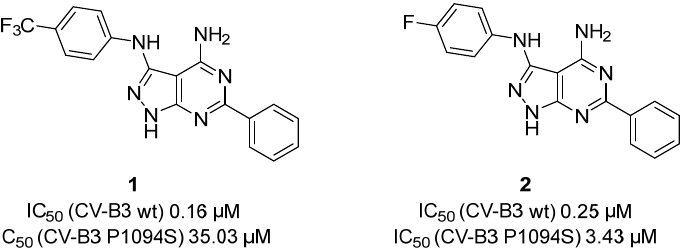
Figure 4. Chemical structures and anti ‐ viral activities of compounds 1 and 2 .